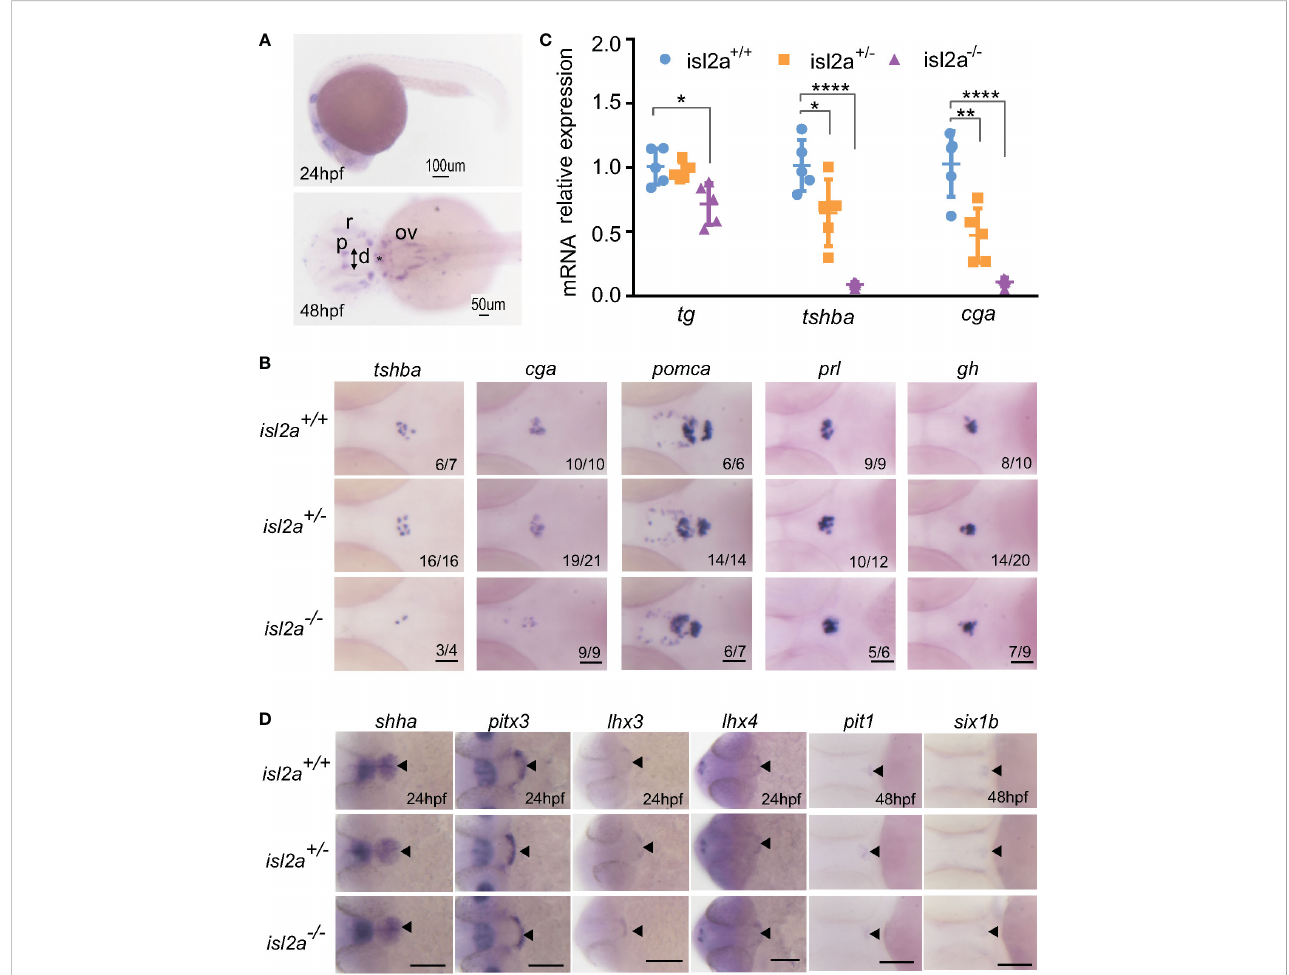
FIGURE 2 Effect of isl2a knockout on the expression of genes involved in pituitary development via whole-mount in situ hybridization. (A) Spatiotemporal expression patterns of isl2a by whole-mount RNA in situ hybridization at 24 and 48 hpf. Scale bars = 100 µm/50 µm. Asterisks (*) indicate the position of midbrain- hindbrain boundary. p, pineal gland; r, retinal; ov, otic vesicle; d, diencephalon. (B) Knockout of isl2a resulted in reduced tshba and cga expression, while the expression of pomca , prl , and gh was not changed in larvae at 3 dpf. Pituitary precursors differentiate into speci fi c cell types with markers, including gh (for somatotropes), tshba (for thyrotropes), cga (for thyrotropes and gonadotropes), prl (for lactotropes), and pomca (for corticotropes and melanotropes). All images are dorsal views with the head pointing towards the left. Scale bar = 50 µm. Numbers indicate the ratio of embryos with the shown phenotype. (C) qRT-PCR analysis demonstrates the expression of total tg , tshba and cga in isl2a +/+ , isl2a +/ − and isl2a − / − larvae at 3 dpf. Data is represented as mean ± SD (n = 5, 15 fi sh per tube). *P<0.05, **P<0.01, ****P<0.001. (D) Ventral views of embryos at 24 hpf show no differences in shha , pitx3 , lhx3 and lhx4 expression in isl2a mutants. Dorsal views of embryos at 48 hpf show no difference in gene expression, indicating speci fi cation of pit-1 lineage ( pit1 , for somatotropes, thyrotropes, and lactotropes) or non-pit-1 lineage ( six1b for corticotropes, gonadotropes, and melanotropes). Thus, pituitary induction and lineage speci fi cation were unaffected in isl2a mutants. Scale bar = 100 µm. The black triangle indicates gene expression in the adenohypophyseal